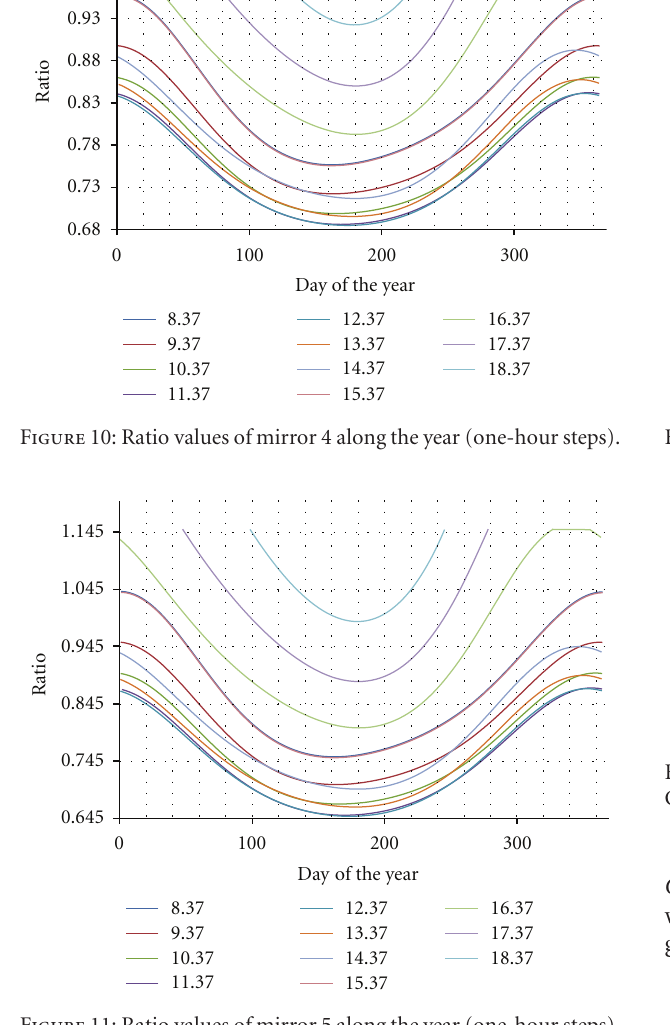
Figure 11: Ratio values of mirror 5 along the year (one-hour steps).